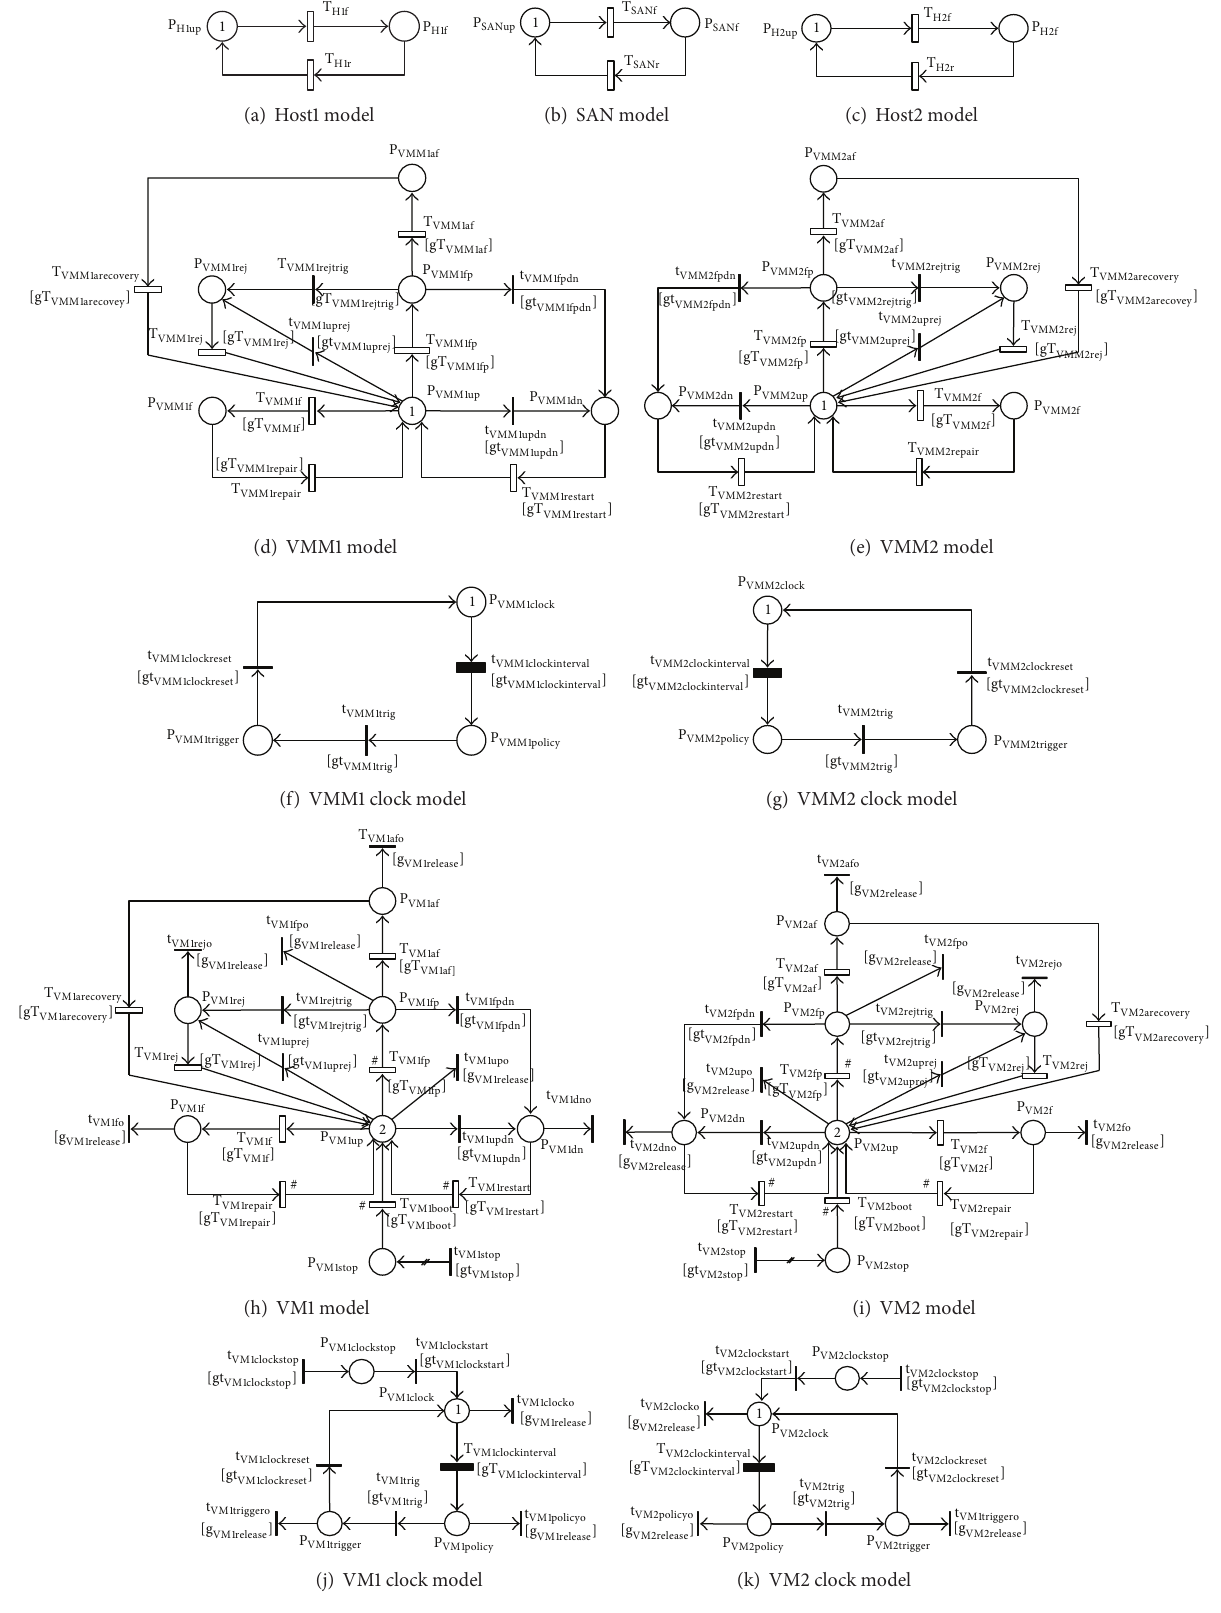
Figure 2: SRN models of a VSS with multiple virtual